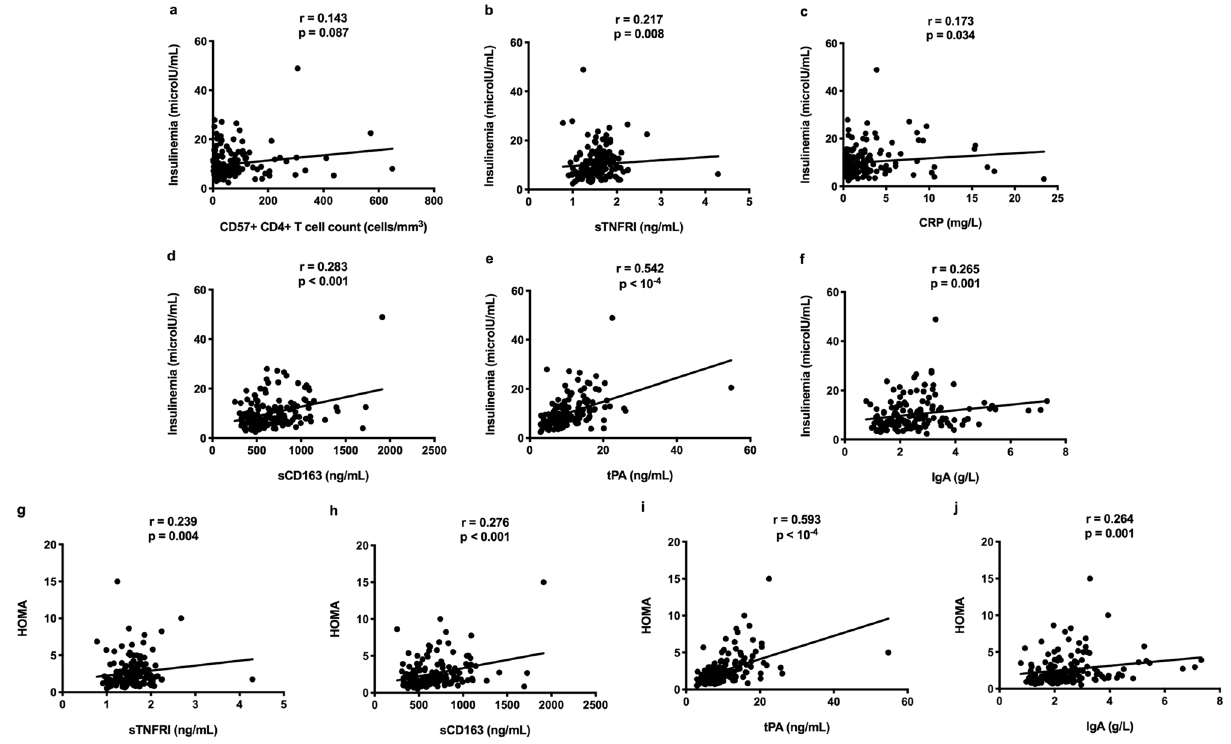
Figure 5. Links between various activation markers, insulinemia and HOMA in the whole